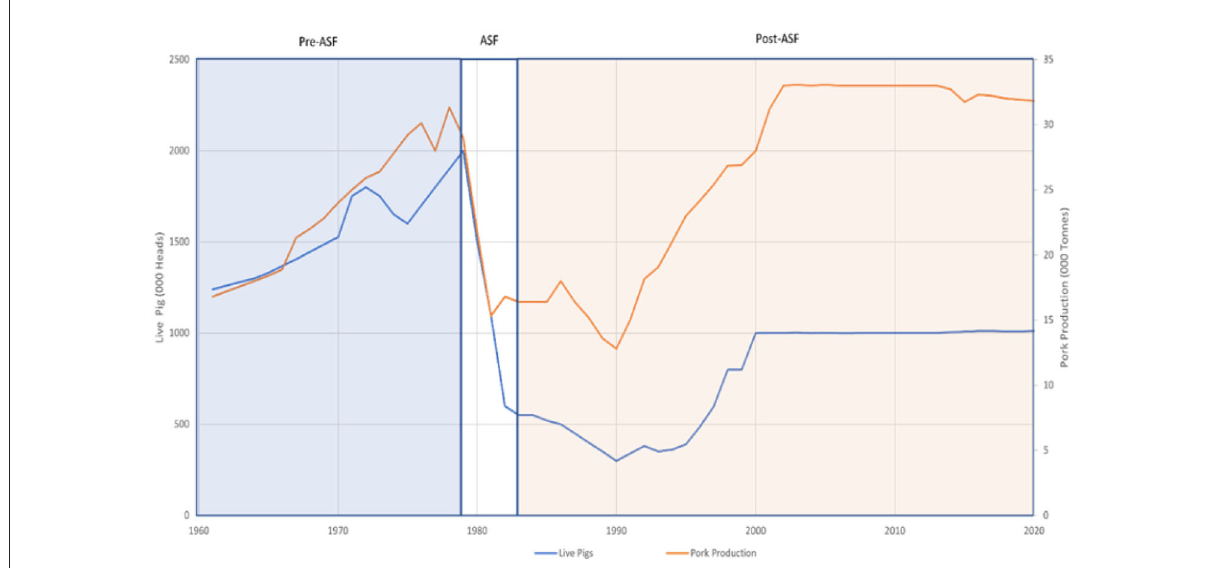
FIGURE1 Comparison of live pigs and pork processed before, during, and after African Swine Fever in